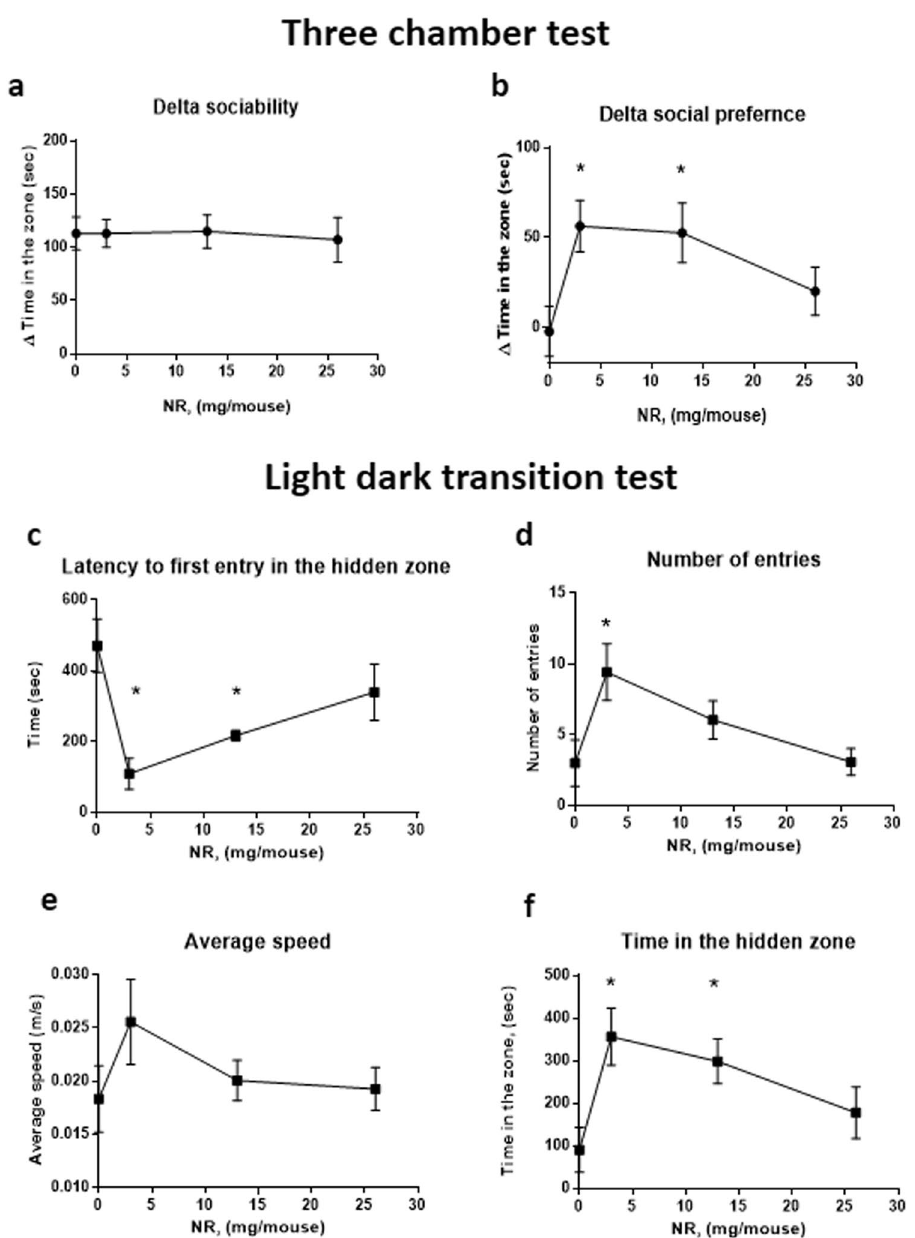
Figure 5. Effects of different doses of nicotinamide riboside (NR) on CD157KO mice in the three-chamber and light-dark transition tests. Different doses (3–26 mg/mouse) of gavage NR was administered for 12 days. Sociability ( a ) and social preference ( b ) are shown as time with the Stranger 1 subtracted by that with the non- social target or as time with Stranger 2 subtracted that of Stranger 1, respectively, in the three chamber test. One- way ANOVA followed by Bonferroni’s post hoc comparison: F 3,69 = 3.873, P = 0.0128: * P < 0,05, from values with no NR. ( c - f ) Three c hamber box test. ( c ) Latency in first entry into the hidden (dark) compartment (One way ANOVA followed by Bonferroni’s post hoc comparison F 3,41 = 3.698, P = 0.0191). ( d ) Transition numbers (One way ANOVA followed by Bonferroni’s post hoc comparison F 3,41 = 3.272, P = 0.0306). Bonferroni’s post hoc comparison revealed * P < 0.05 compared with no nicotinamide riboside. ( e ). No dose-dependent e ffect was found in the average speed. ( f ) Time spent in the hidden zone (One way ANOVA followed by Bonferroni’s post hoc comparison F 3,41 = 3.357, P = 0.0278). Bonferroni’s post hoc comparison revealed * P < 0.05 compared without